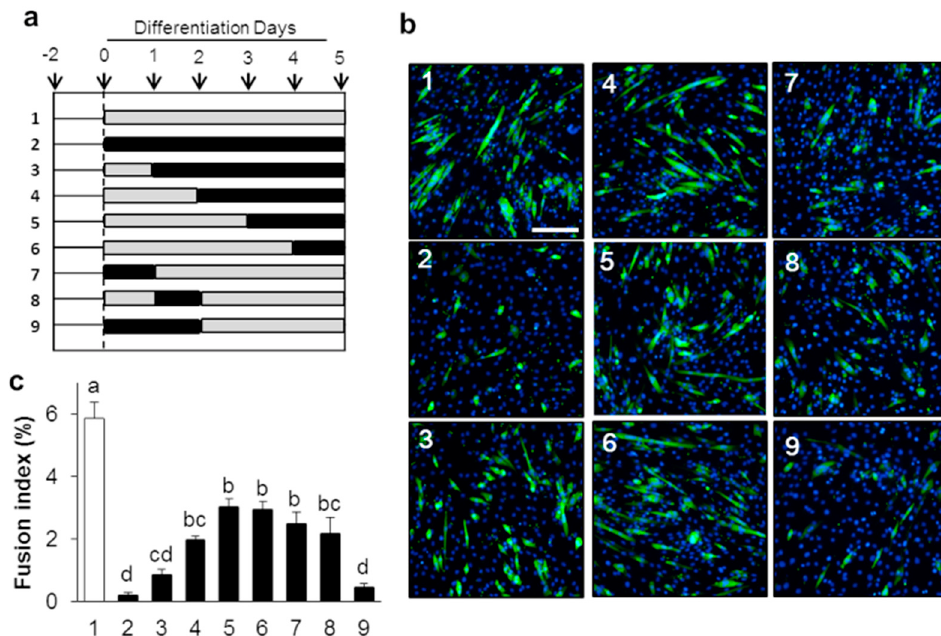
Figure 2. IRE1 ribonuclease activity is required in early phase of C2C12 differentiation. ( a ) Differentiation was induced in the presence or absence of IRE1 RNase inhibitor, STF-083010 (60 µM; black bars) or DMSO (gray bars) for various time intervals as indicated. ( b ) Identification of critical time period for inhibitory effect of IRE1 activity on C2C12 differentiation. Scale bar = 200 µm. ( c ) Fusion index of STF-083010- or DMSO-treated cells. Results are mean + SEM (three biological replicates). The different letters denote significant differences between groups at p < 0.05 by Tukey’s HSD test.